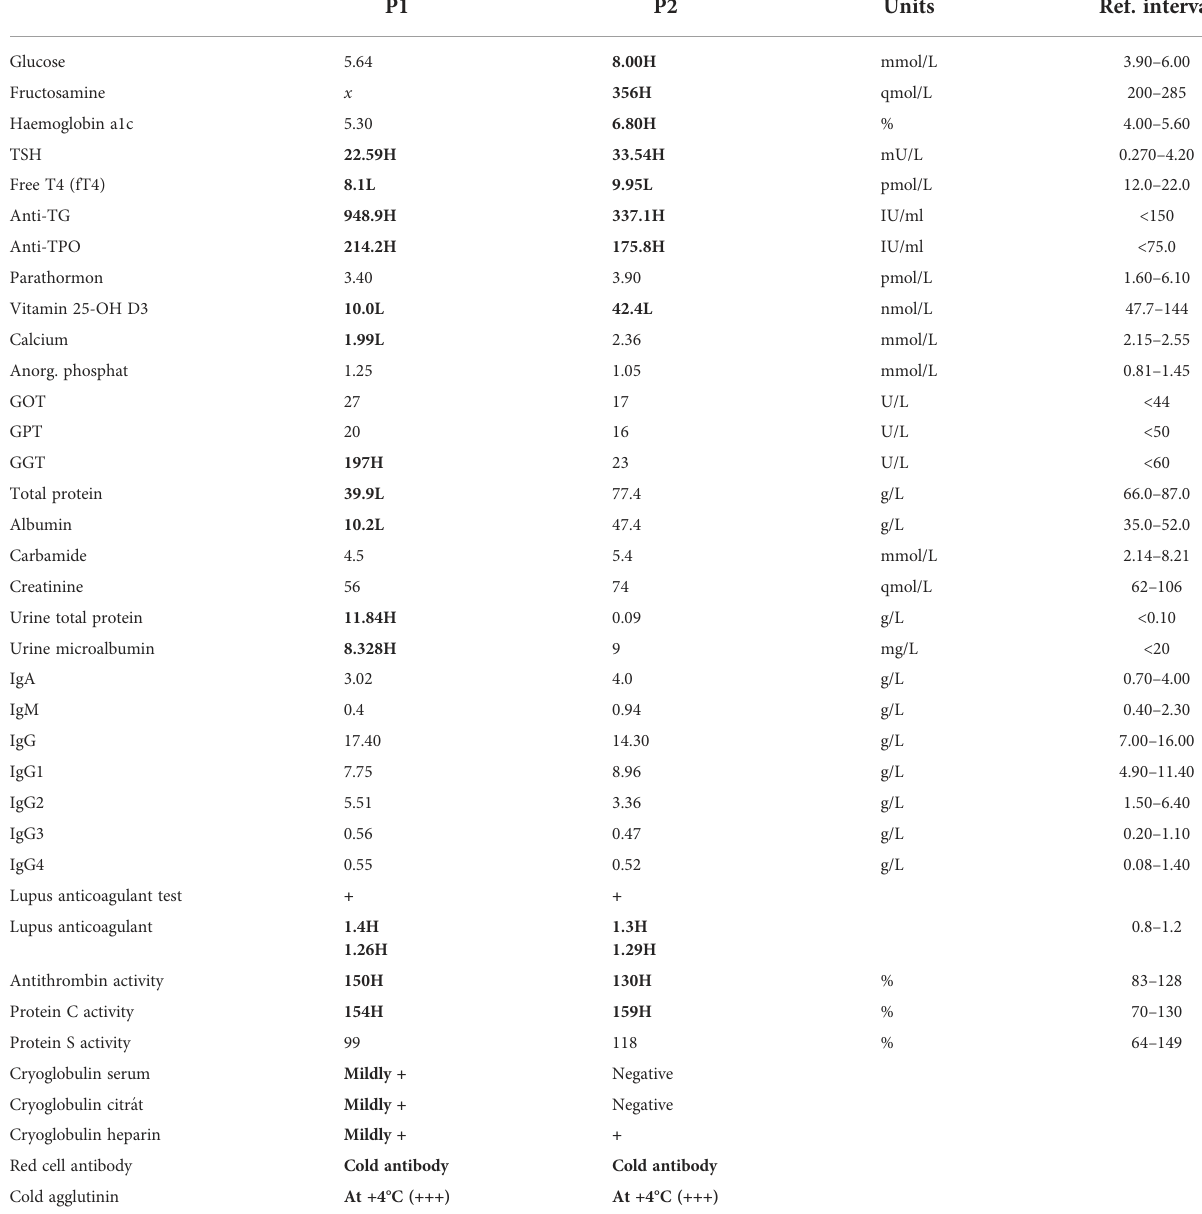
TABLE 1 Routine laboratory tests, immunohematology I (H, high; L, low). P1 P2 Units Ref.